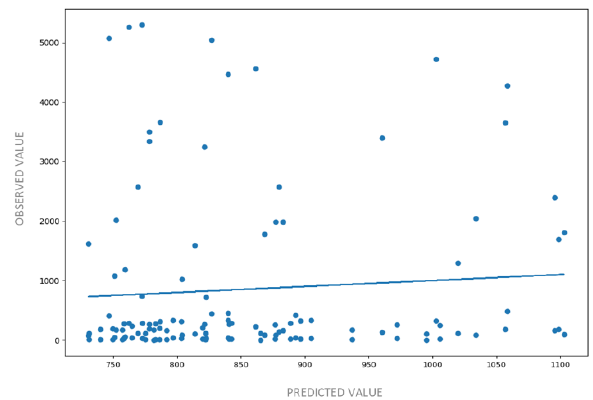
Figure 16 . Predicted against observed number of COVID-19 cases as a function of DSI and NO2 levels. The predicted value was calculated using Eq. (1) which was derived from the multiple regression